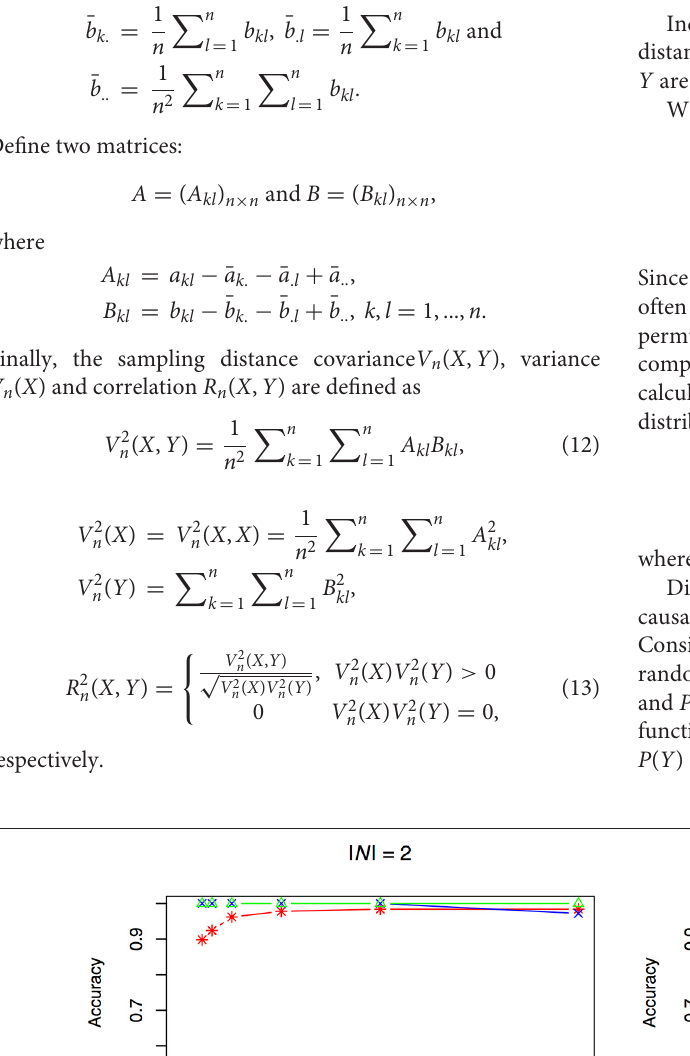
FIGURE 3 | Simulation scenario 1, |N|